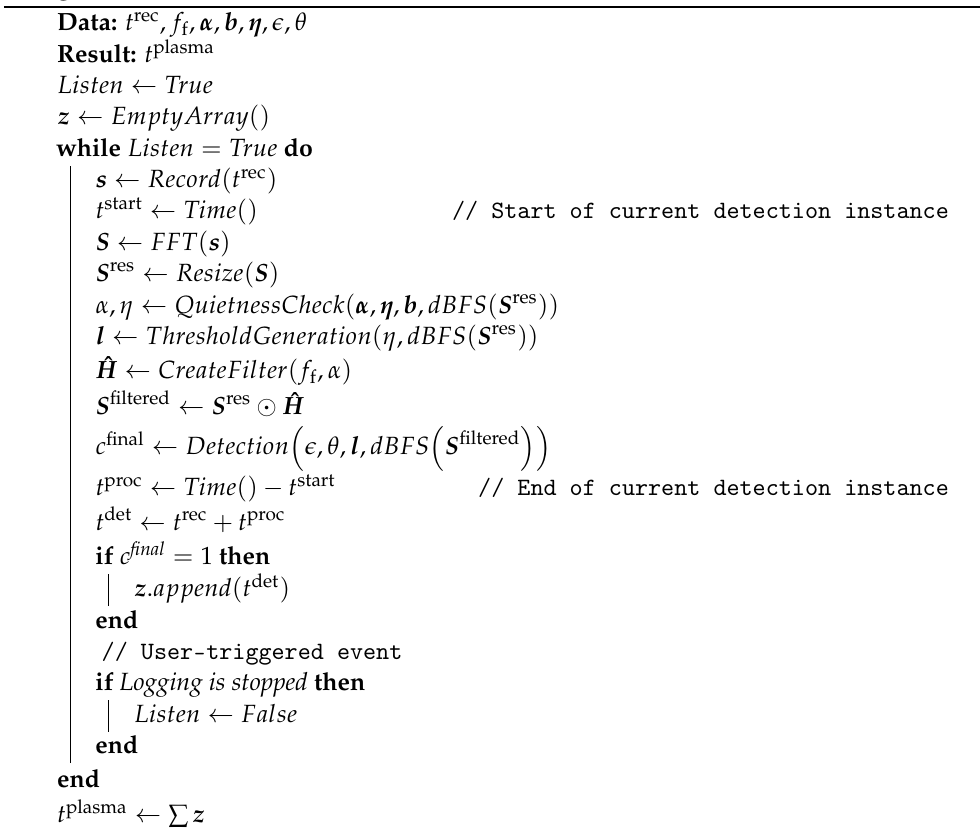
Algorithm 1: Plasma sound detection and treatment time